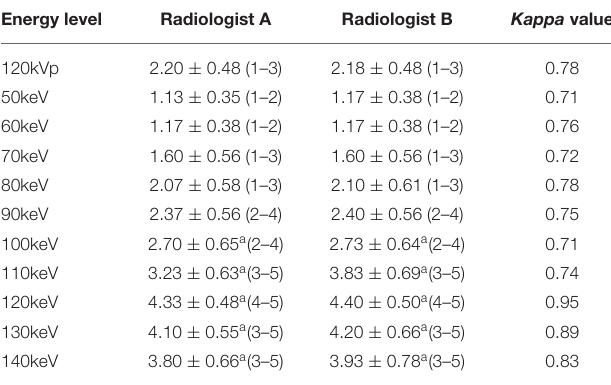
TABLE 5 | Subjective image quality parameters. Energy